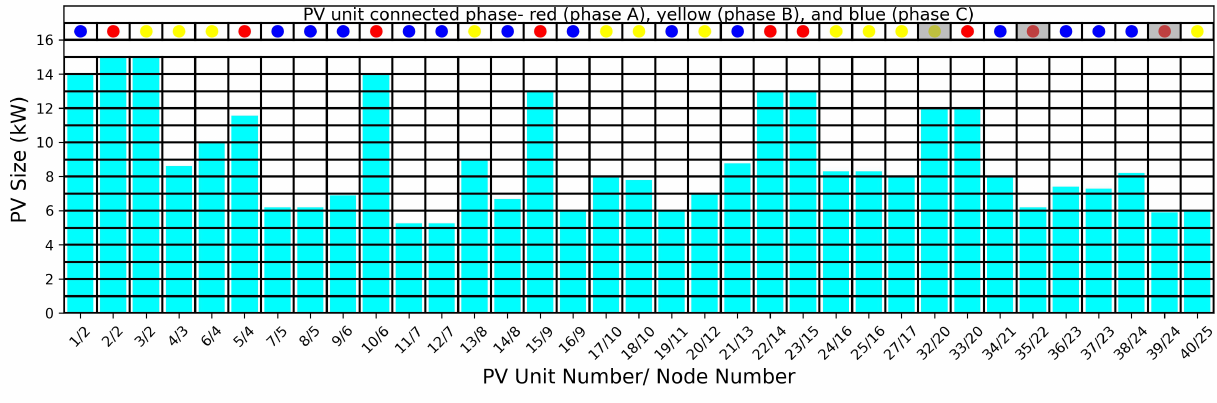
Figure 16. Phase changing of optimized PV sizes.